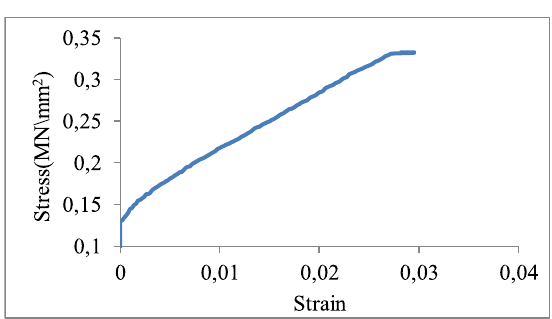
Figure 2. 9 × 19 mm Parabellum